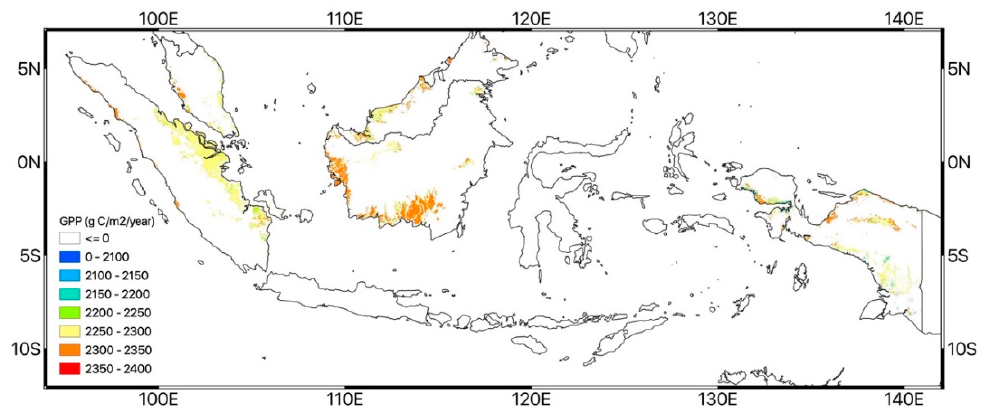
Figure 9. Spatial distributions of the annual averaged gross primary production (GPP) from 2002 to 2018 based on the calibrated MOD17A2H created by using the drained forest (DF), flux tower-derived GPP in this study.